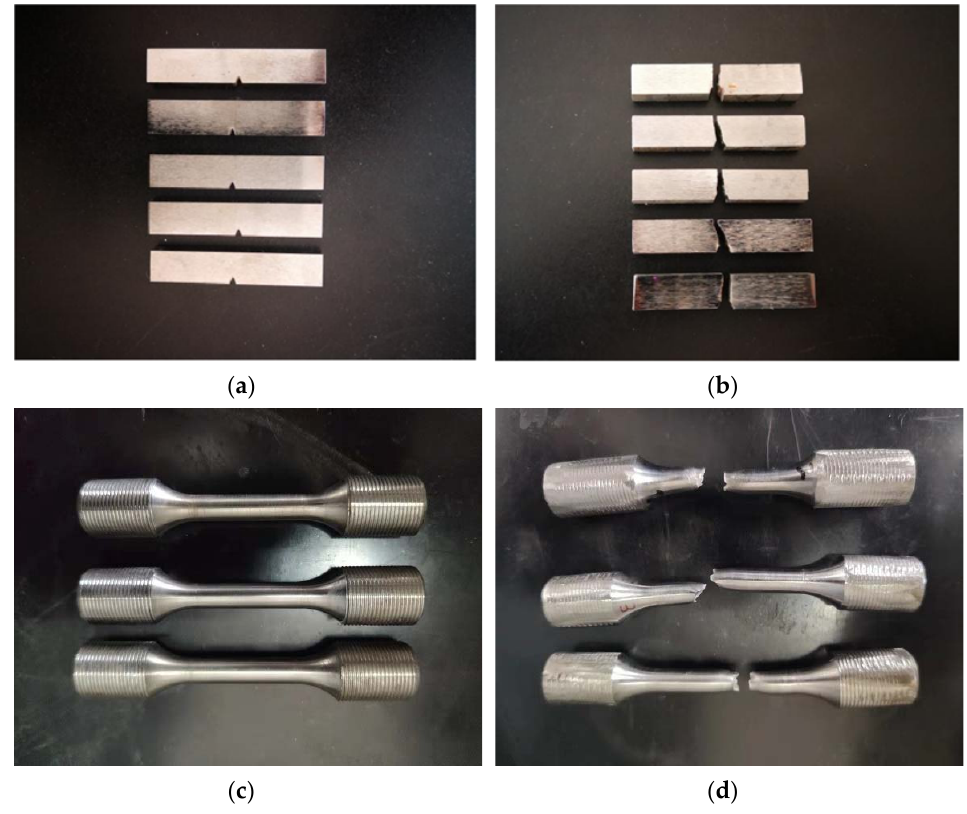
Figure 3. Impact test specimen and tensile test specimen of weld metal. ( a ) No impact. ( b ) After impact. ( c ) No stretched. ( d ) After stretched.